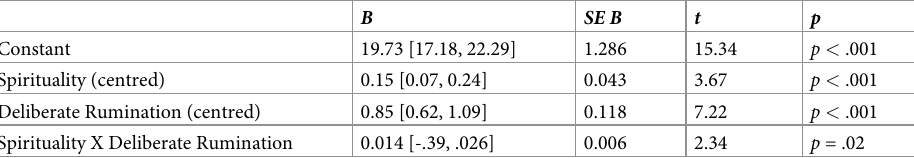
Table 4. Linear model of predictors of PTG.